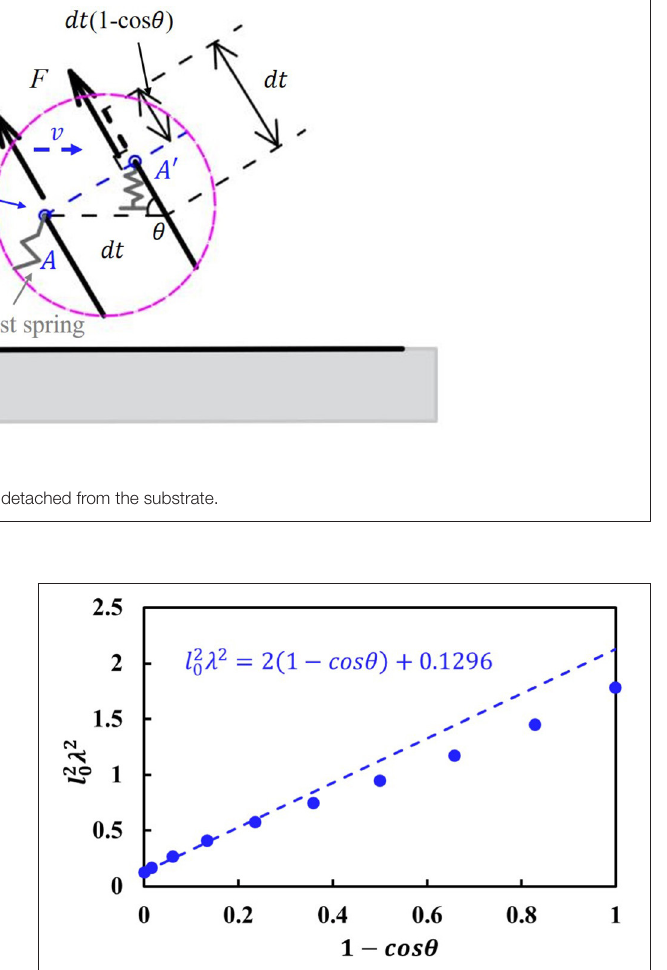
FIGURE 4 | The relationship between l 2 0 λ 2 and (1 − cos θ ). The data marked with circle are predicted by the numerical solution, and the dashed line is predicted by the approximate analytical